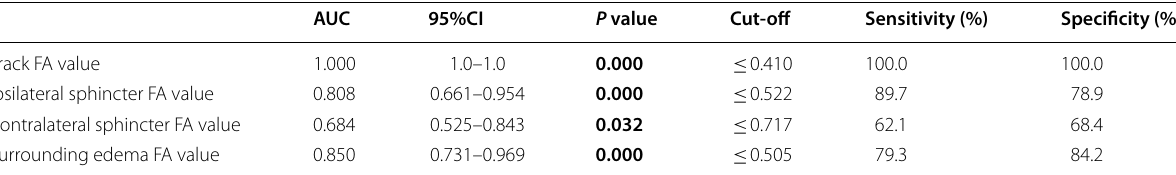
Table 1 ROC curve analysis for FA measures